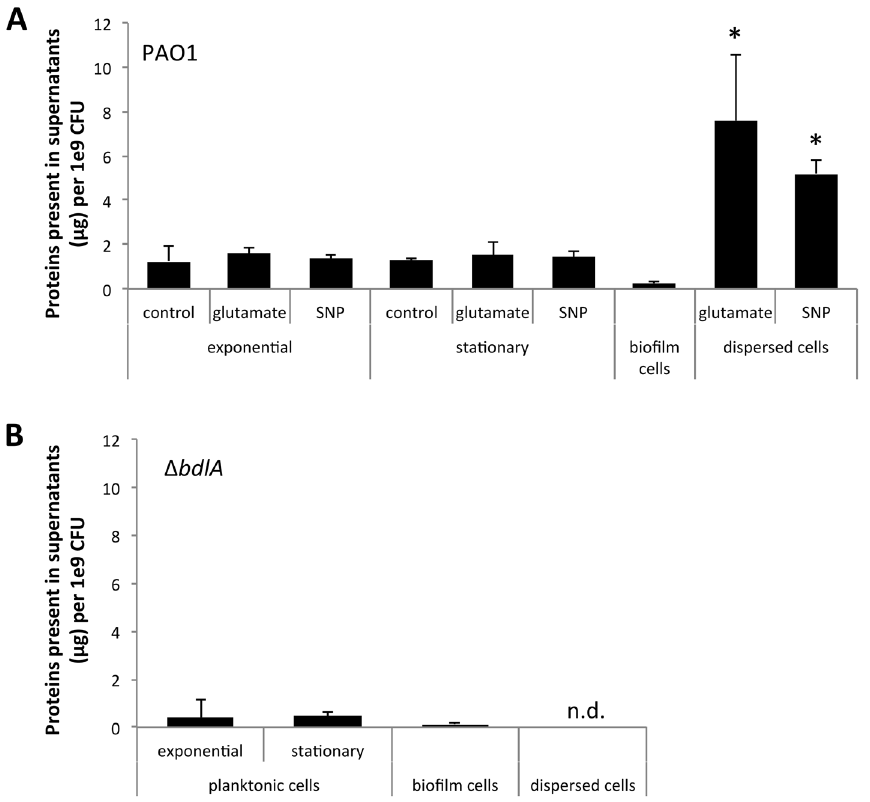
Figure 1. Dispersion of P.aeruginosa PAO1 biofilms correlates with increased release of proteins into the supernatant. Supernatants were obtained from (A) P. aeruginosa PAO1 and (B) D bdlA grown planktonically to exponential and stationary phase, as well as from biofilms and cells dispersed from the biofilm in response to exposure to glutamate (dispersed cells). Dispersed cells were obtained following dispersion in response to glutamate and SNP, which was used as a source of nitric oxide. Likewise, planktonic cells grown to exponential and stationary phase were exposed for 20 min to glutamate or SNP. Planktonic cells not treated with glutamate or nitric oxide are referred to as ‘‘control’’. Experiments were carried out in triplicate. Error bars indicate standard deviation. The protein concentration of supernatants was determined using the same number of cells (1x10 9 CFU/ml) regardless of growth conditions. n.d., not determined.